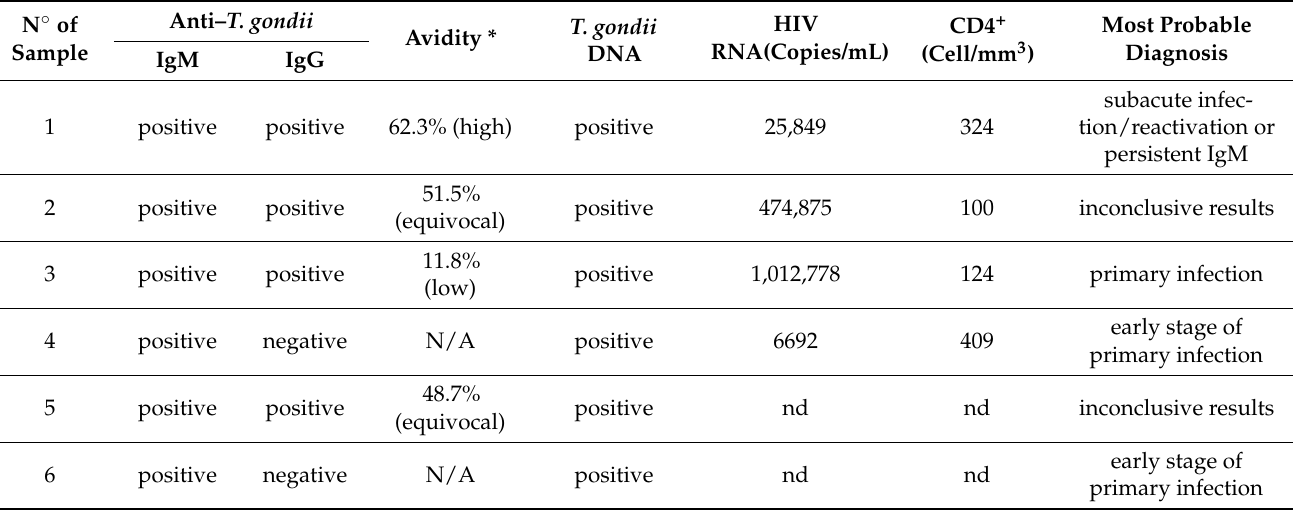
Table 3. Concomitant presence of IgM antibodies and T. gondii DNA among HIV-1-infected patients. N ◦ of